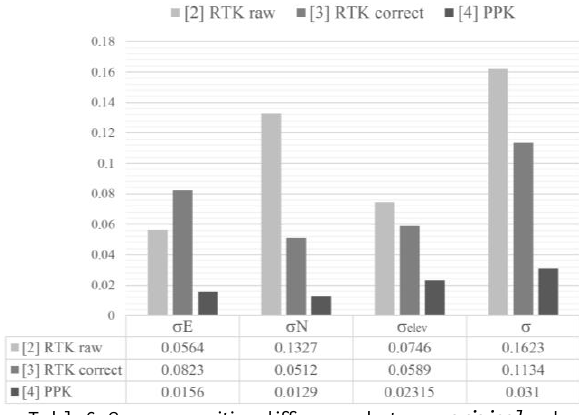
Table 6. Camera position differences between original and